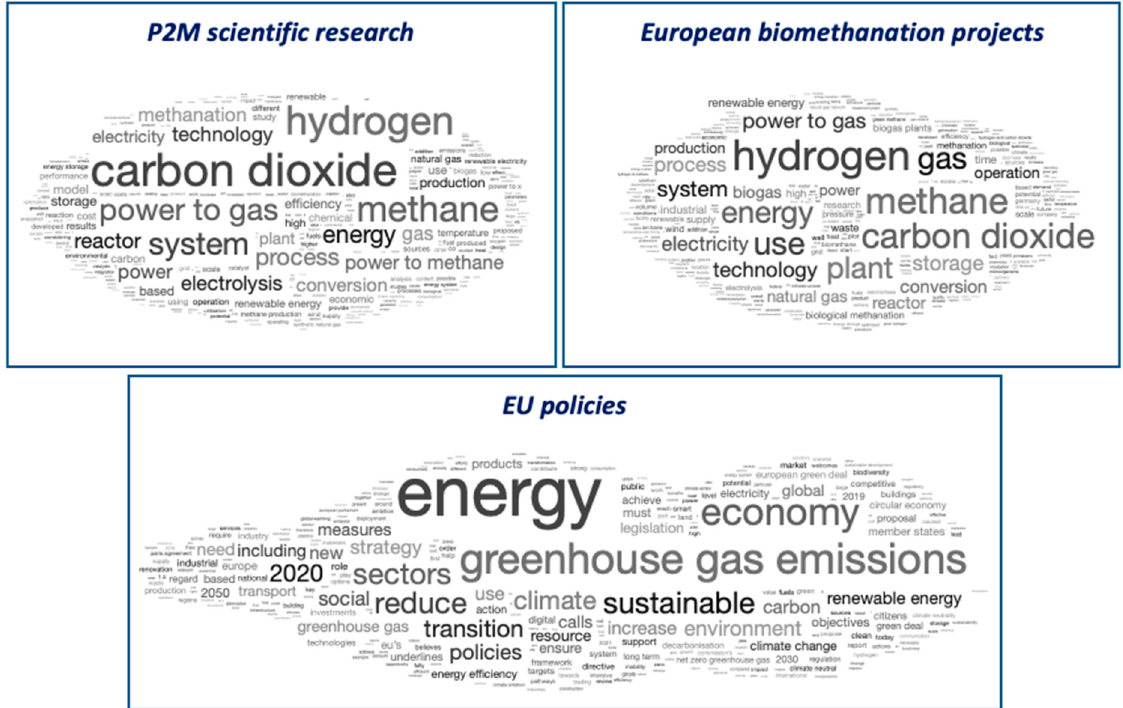
Figure 6. Comparing the word clouds of biomethanation project descriptions, P2M publications, and relevant EU policies.